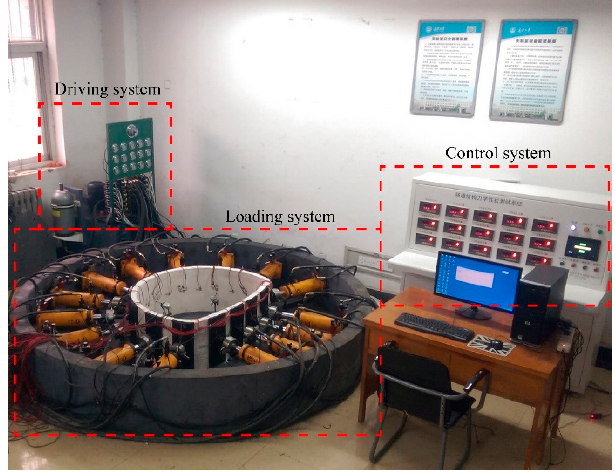
Figure 10. Experimental system.